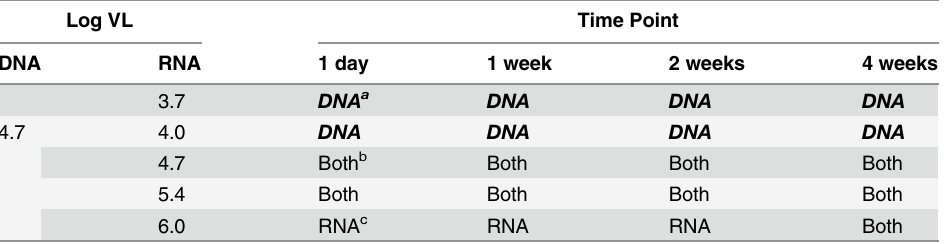
RNA c RNA RNA Both a DNA detected, RNA not detected; Values where RNA was not detected are emphasised in bold b Both: DNA and RNA detected c RNA: RNA detected, DNA not